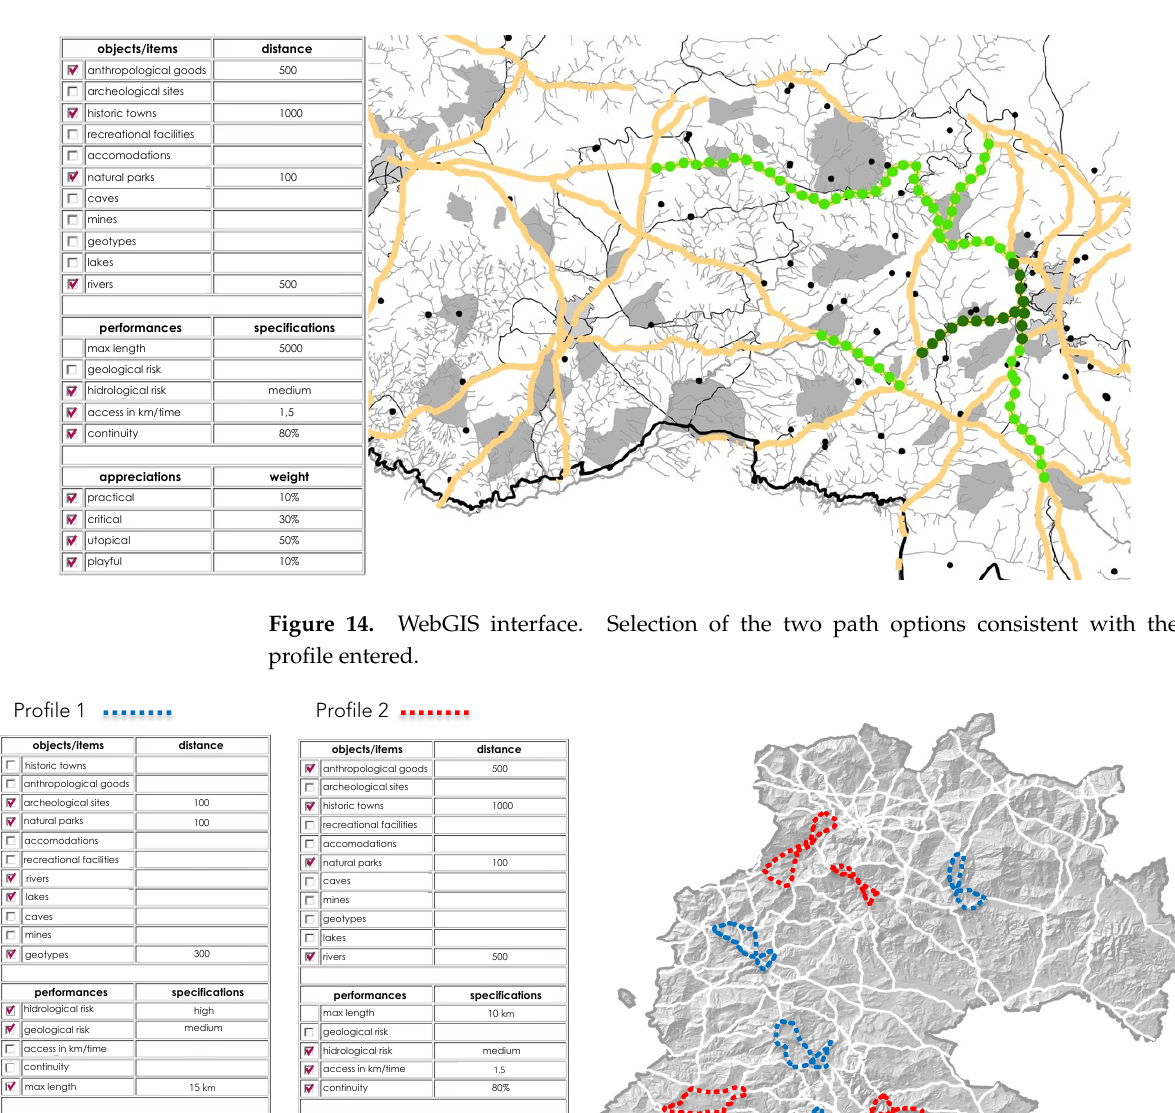
Figure 13. Playful values. Mapping and value functions.